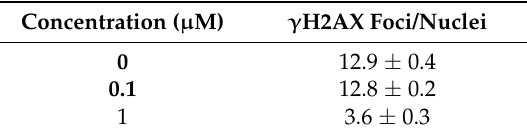
Table 4. DNA damage assay of Compound 1